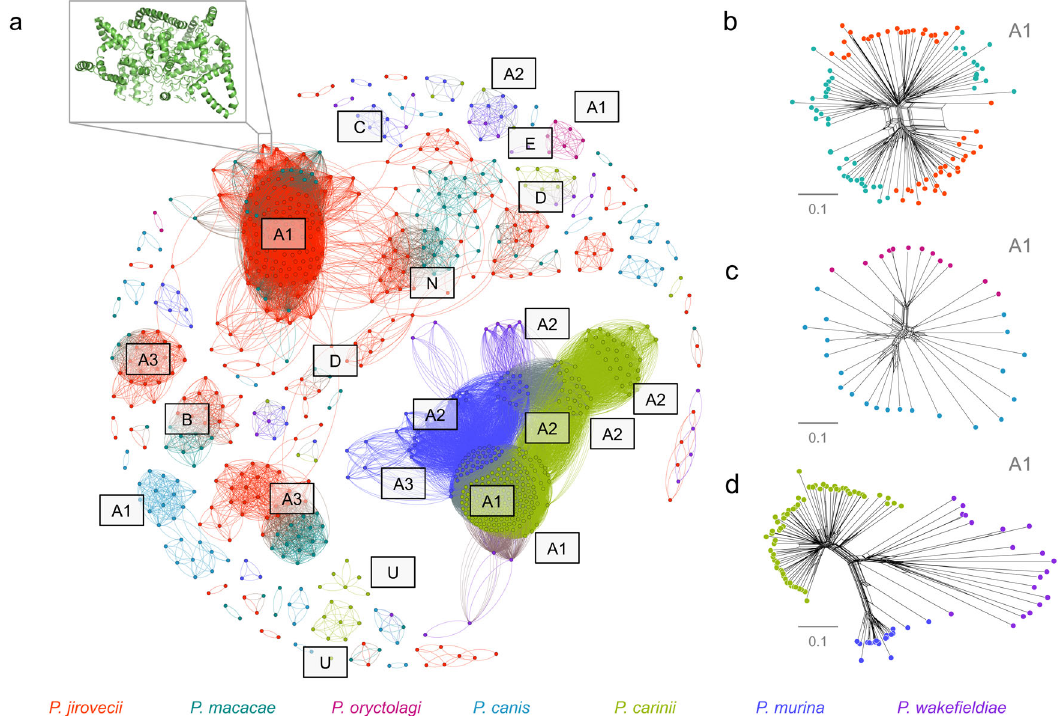
Fig. 4 Clustering of Pneumocystis major surface glycoproteins (Msg). a Graphical representation of similarity between 482 Msg proteins from seven Pneumocystis species generated using the Fruchterman Reingold algorithm. A 3-D model of a representative member of Msg-A1 protein family (NCBI locus tag T551_00910) generated using DESTINI is presented in the upper left insert. Individual protein sequences are shown as dots and color-coded by species as shown at the bottom of the fi gure. The edge between two dots indicates a global pairwise identity equal or greater than 45%. The letters represent Msg families (A to E) and subfamilies (A1 to A3). N and U letters represent potentially novel Msg sequences (relative to our prior study 35 ) and unclassi fi ed sequences, respectively. For sake of clarity only the major clusters were annotated. b Phylogenetic network of a subset of Msg-A1 family ( n = 97) in primate Pneumocystis including P. jirovecii (red) and P. macacae (dark cyan) suggesting recombination events at the root of the network. Nodes with more than two parents represent reticulate events. Bars represent the number of amino acid substitutions per site. c Phylogenetic network of Msg family A1 ( n = 33) in P. oryctolagi (red violet) and P. canis (light blue). d Phylogenetic network of Msg-A1 family ( n = 113) in rodent Pneumocystis including P. carinii